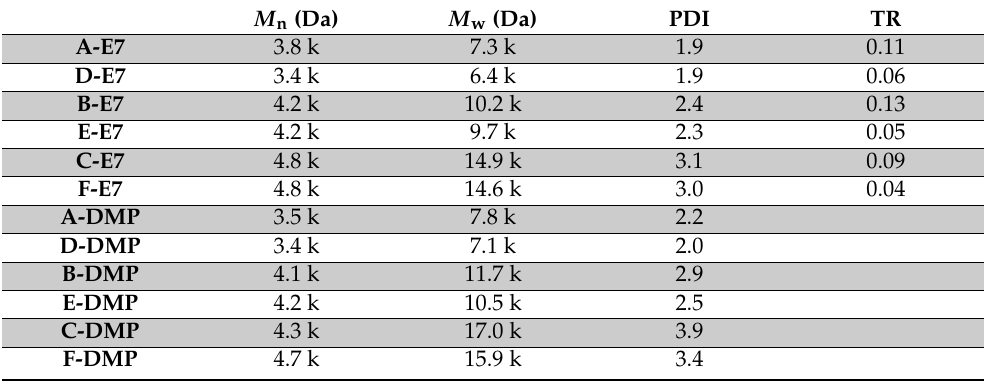
Table 1. Characterising HPAEs with non-ideal (D, E, F) or only ideal terminations (A, B,